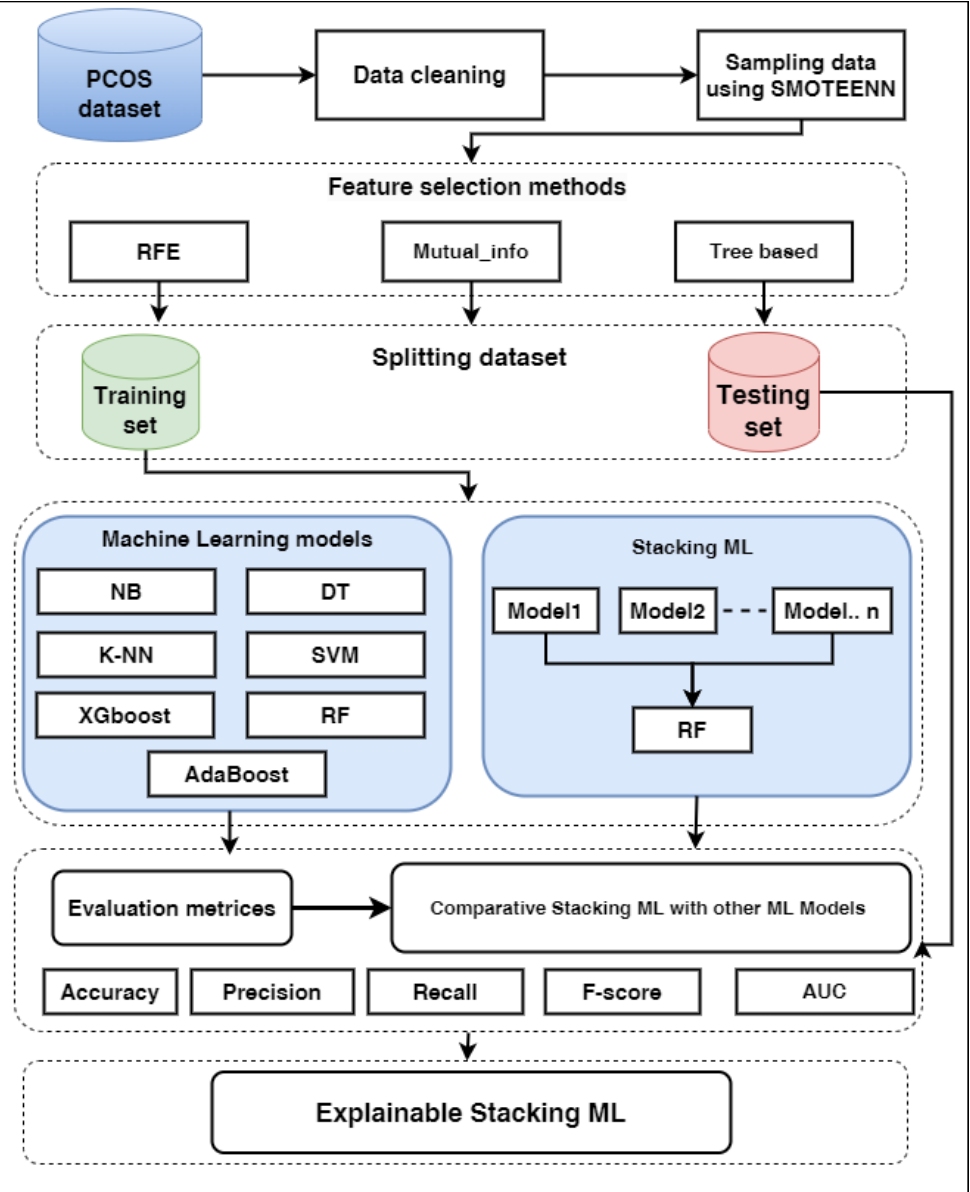
Figure 1. The phases of prediction